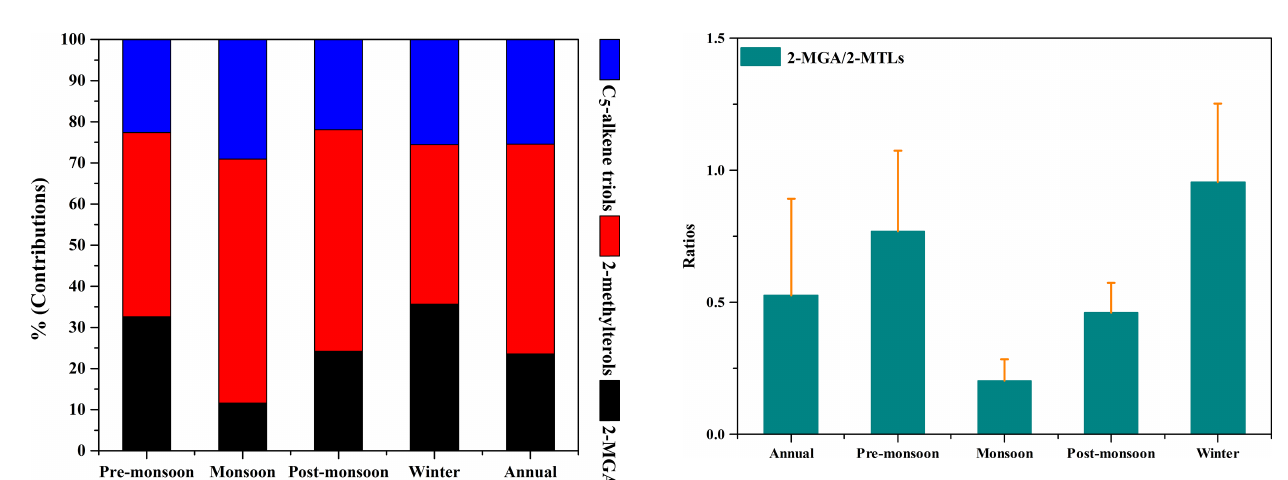
Figure 6. The percentage contributions of the isoprene SOA tracers to the total during different seasons in the atmospheric aerosols from Kathmandu.